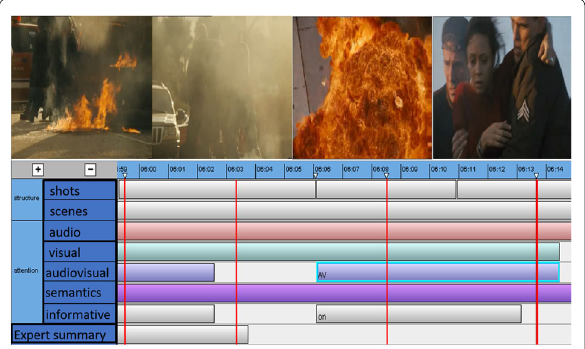
Fig. 1 Interface for saliency annotation, showing the different annotation layers and the respective key frames ( redlines show the time instances of the specific frames) that were labeled as either salient or not in each